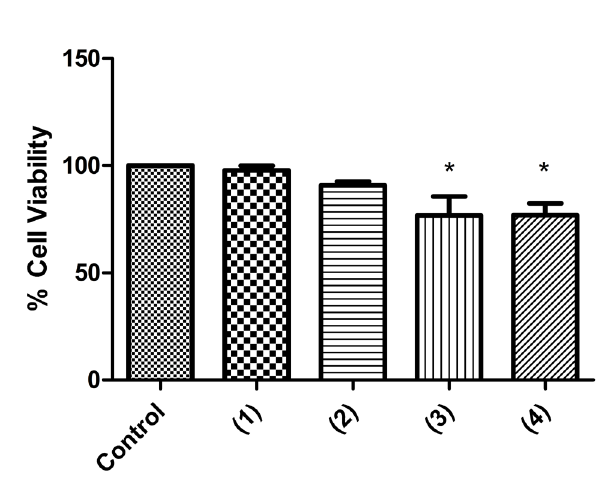
FIGURE 5 - Effect of pure compounds on tumor cell viability. SH-SY5Y human neuroblastoma cells were treated for 72h with analytical standards chlorogenic acid (1), 1,3-dicaffeoylquinic acid (2), apigenin (3) and luteolin (4), at a concentration of 2 µg/mL. Control (MeOH). The viability was evaluated by MTS assay. Mean ± SD is represented for each sample. The asterisks indicate the existence of a significant difference between the compounds and control (p < 0.01, ANOVA statistical test followed by Bonferroni’s post- hoc test was applied).